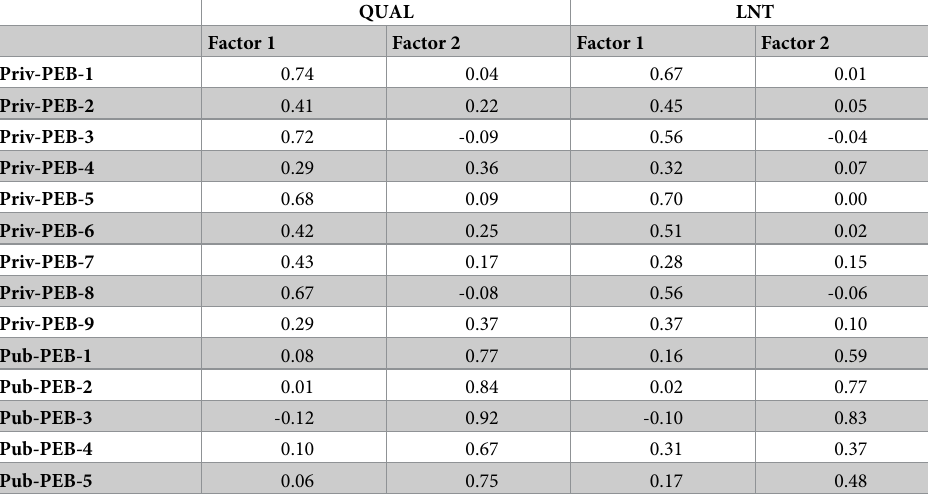
Table 5. Item loadings on two extracted factors for both QUAL and LNT